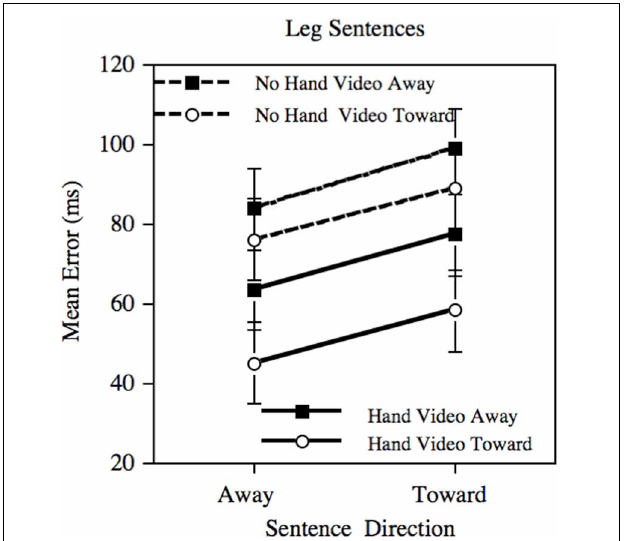
FIGURE 2 | Mean error in prediction following adaptation using the Leg sentences. Error bars depict the standard error of the